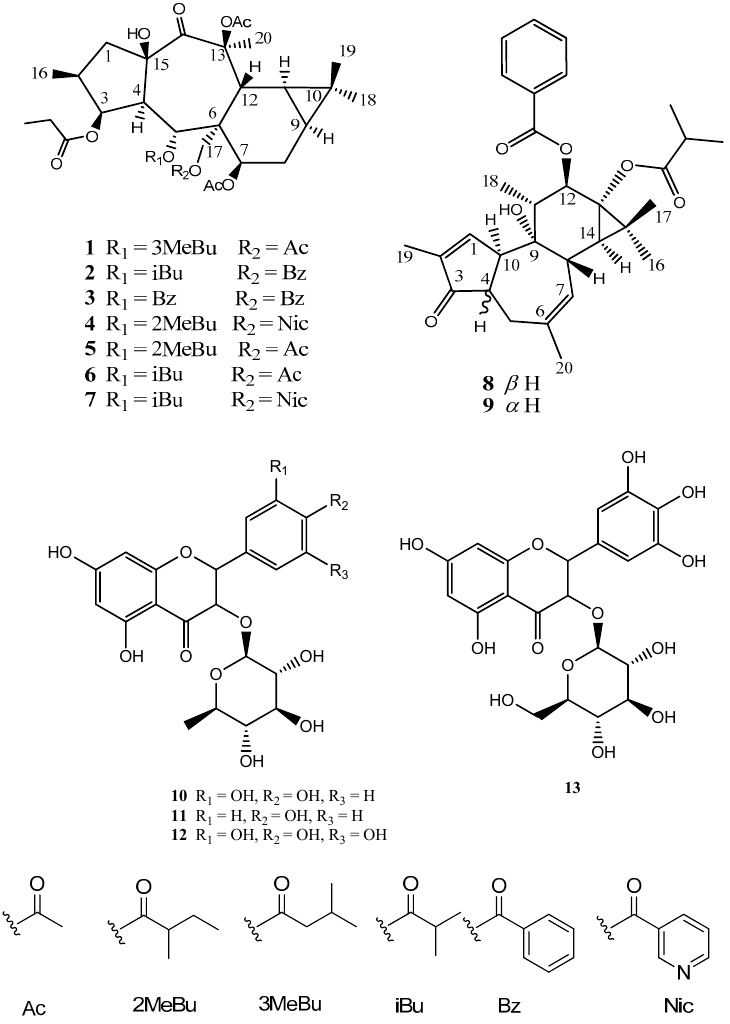
Figure 1. Identified compounds from Euphorbia sanctae-catharinae. Ac = acetyl, Bz = benzoyl, Nic = nicotinoyl, Bu = butanoyl, iBu = isobutanoyl, 2MeBu = 2-methylbutanoyl, 2MeBu 3-dimethylbutanoyl, Nic =